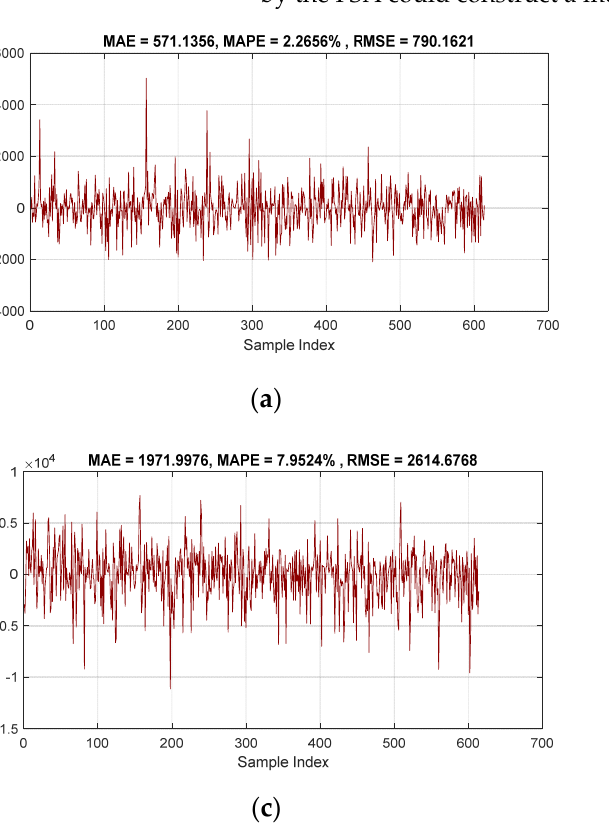
Figure 3. The pure training errors obtained by the ( a ) SOA-ANN, ( b ) FSA-ANN, and ( c ) SSD-ANN. According to the obtained RMSEs, 790.1621, 2215.2954, and 2614.6768for the SOA-